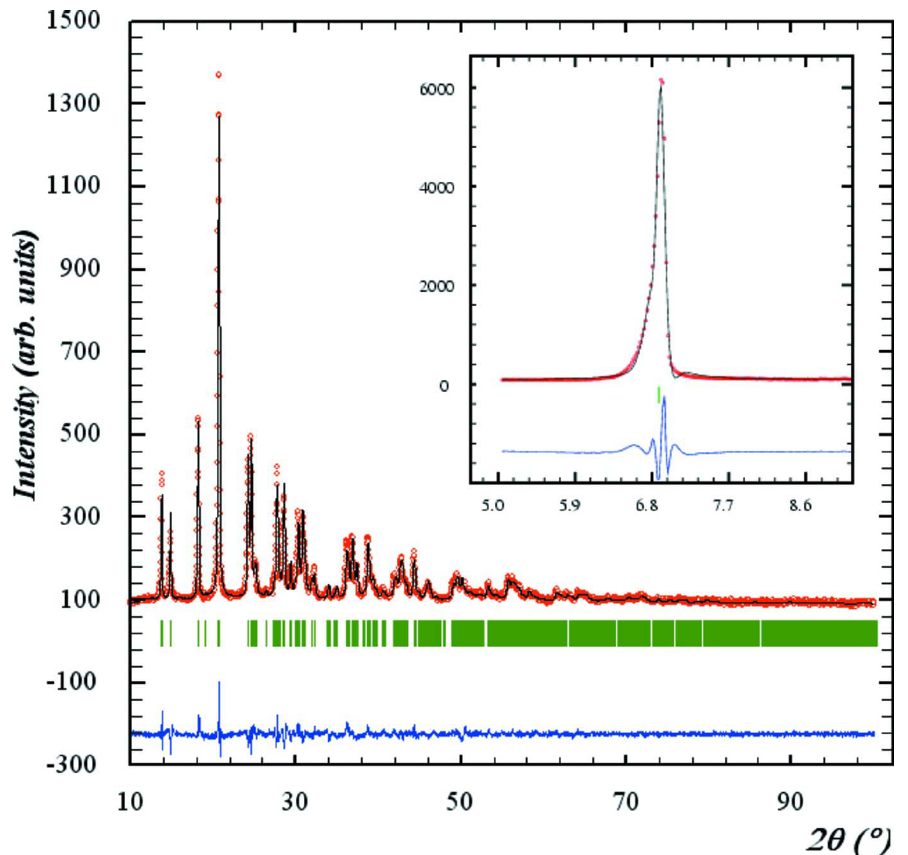
Figure 3 The Rietveld plot, showing the observed (circles), calculated (line) and difference patterns for (I). The reflection positions are shown above the difference